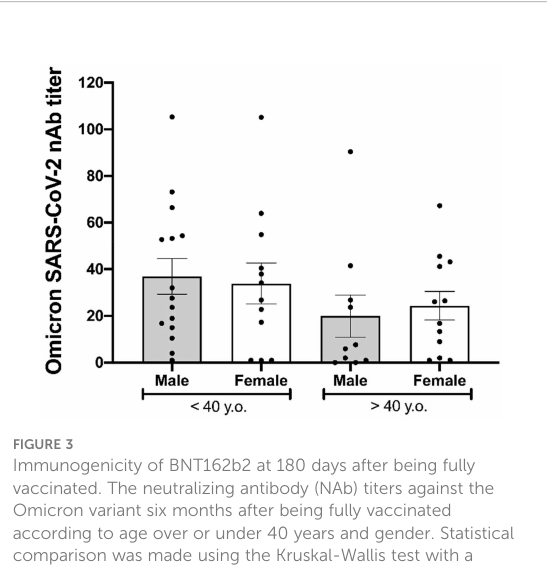
FIGURE 2 Lower NAbs titer against Omicron variant in older donors. The distribution of neutralizing antibody (NAbs) titers after six months of completing the vaccination scheme is shown for the Omicron variant, according to the age distribution of studied individuals. The statistical analysis was performed using Spearman ’ s correlation. Dashed lines indicate the con fi dence interval of data and the continuous line indicates the correlation (average of nAbs titers according to the age of